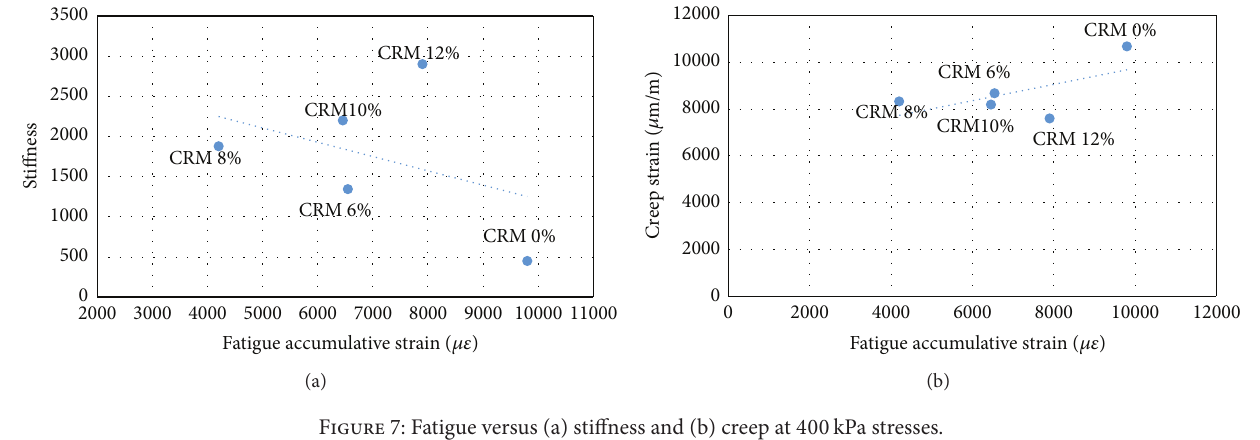
Figure 7: Fatigue versus (a) stiffness and (b) creep at 400kPa